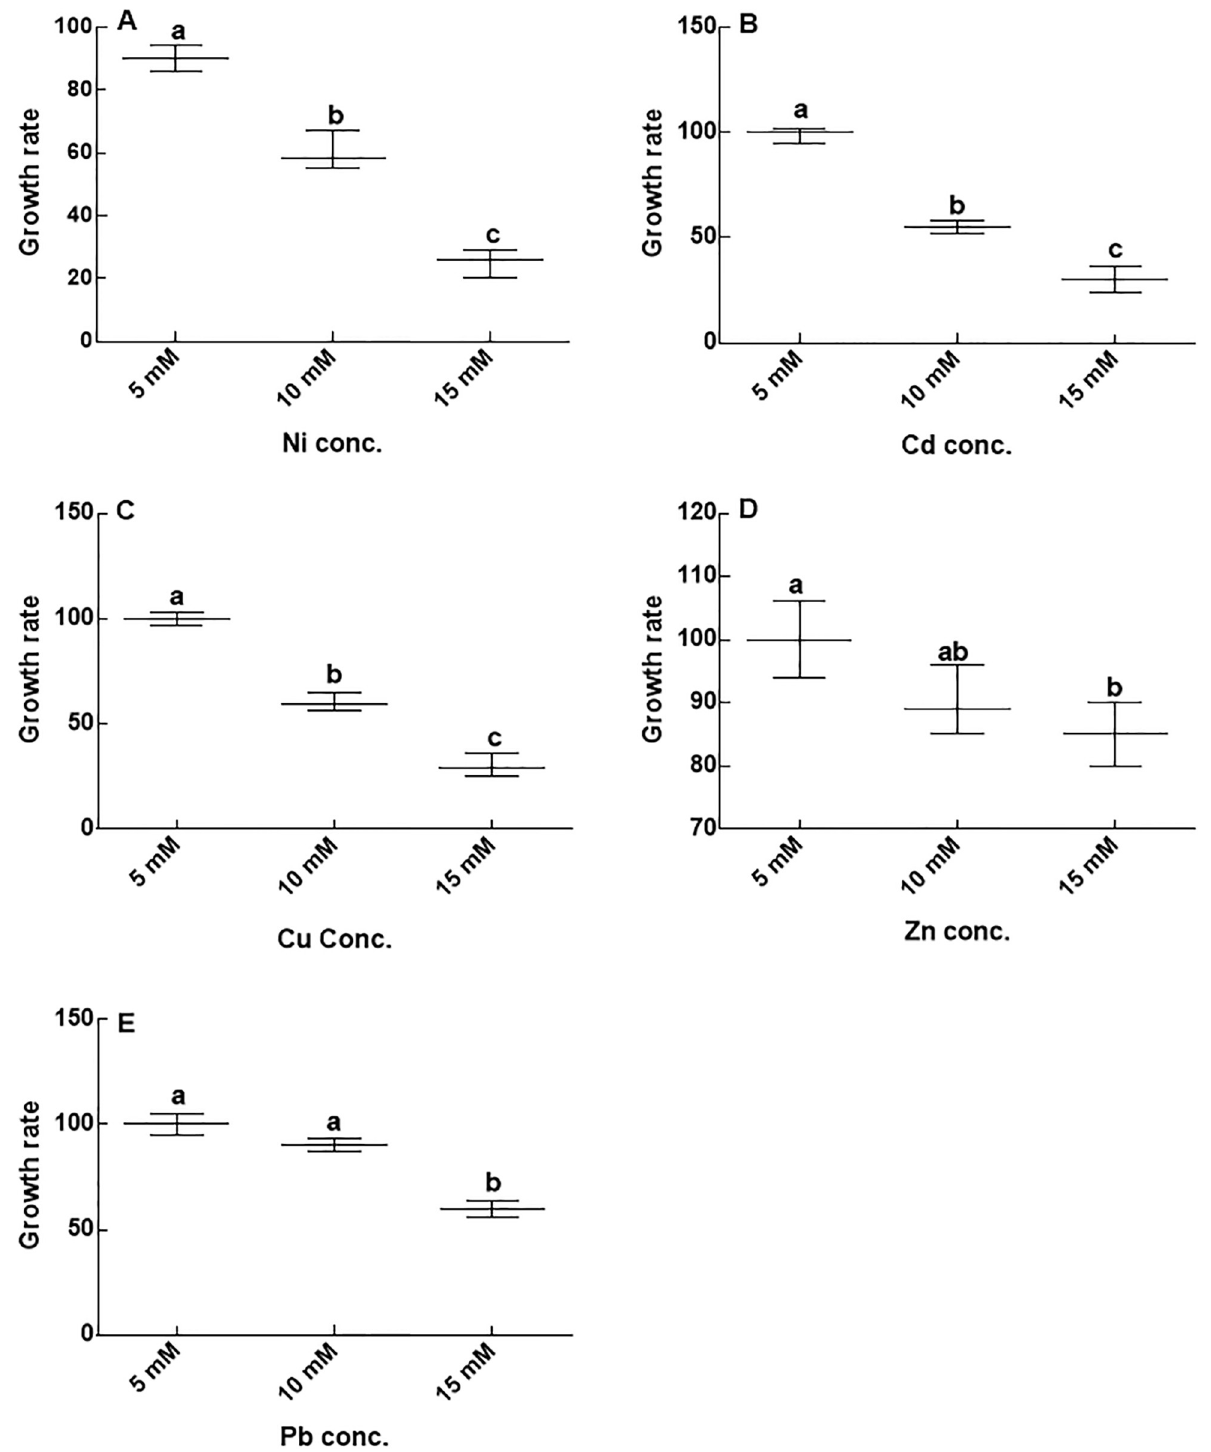
Fig 3. Metal resistance assay of CGF-1. Fig 3A = growth of CGF-1 on various concentration of nickle; Fig 3B = growth of CGF-1 on various concentration of cadmium; Fig 3C = growth of CGF-1 on various concentration of copper; Fig 3D = growth of CGF-1 on various concentration of Zn; Fig 3E = growth of CGF-1 on various concentration of lead; Ni = nickel; Cd = cadmium; Cu = copper; Zn = zinc; Pb = lead. The experiment was carried out in triplicate. The boxplots having different letters are significantly different from each other at P < 0.05.